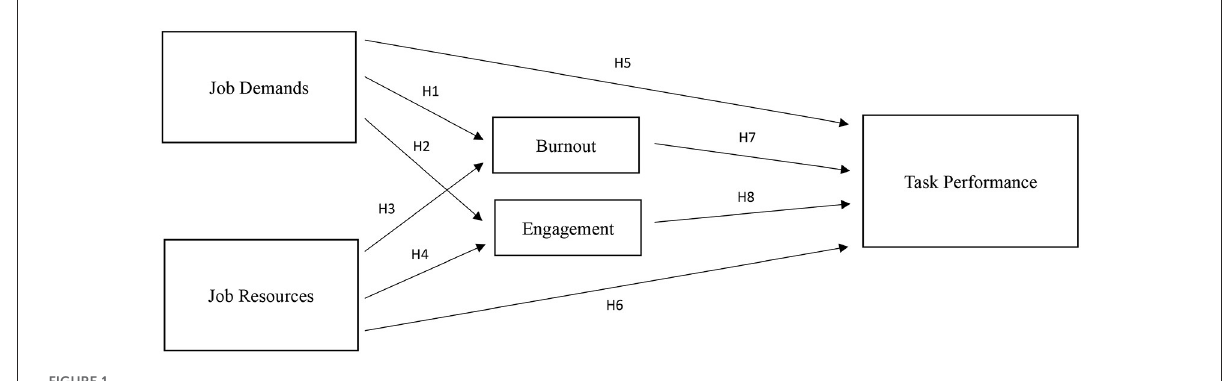
FIGURE1 Conceptual model.